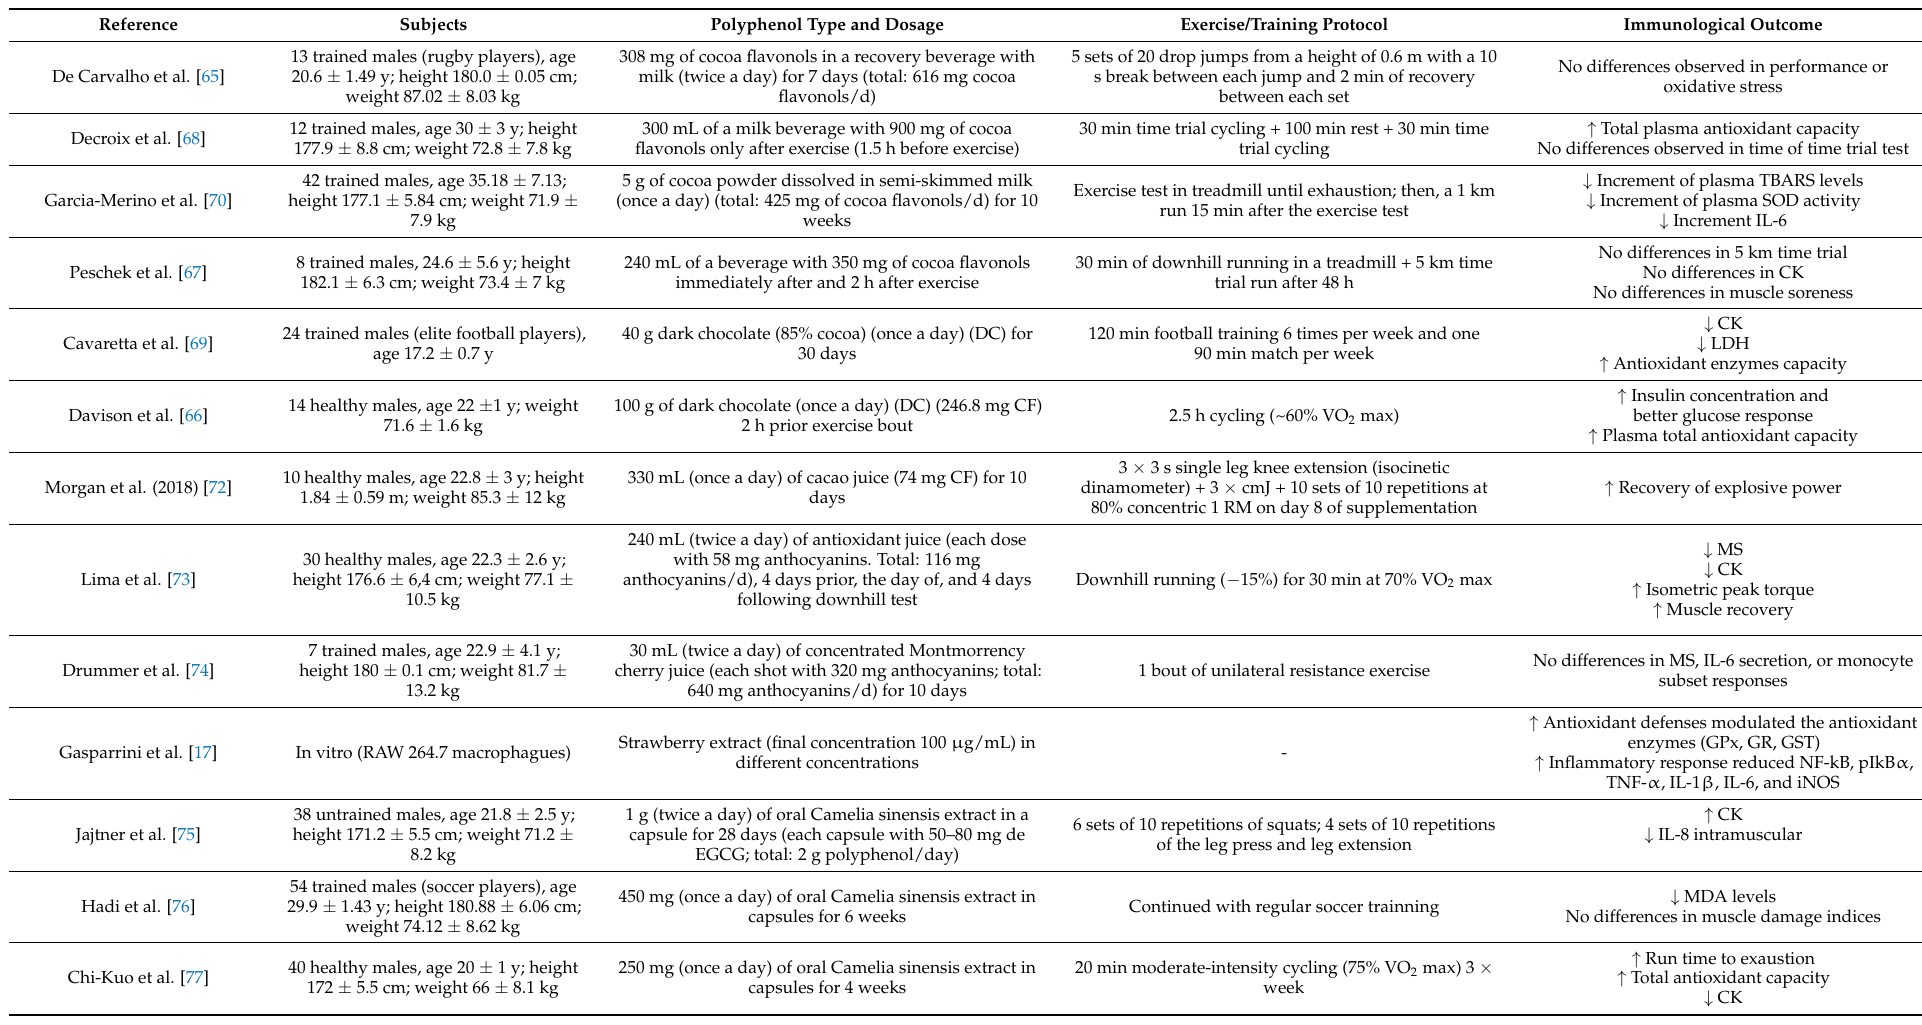
Table 1. The effect of oral polyphenol supplementation associated with physical exercise/training on